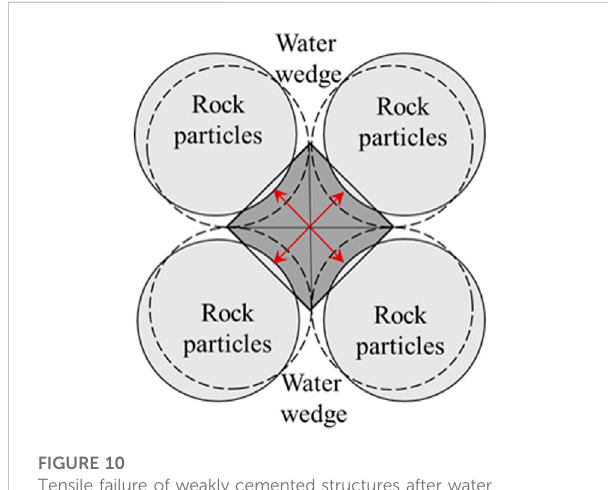
FIGURE 10 Tensile failure of weakly cemented structures after water